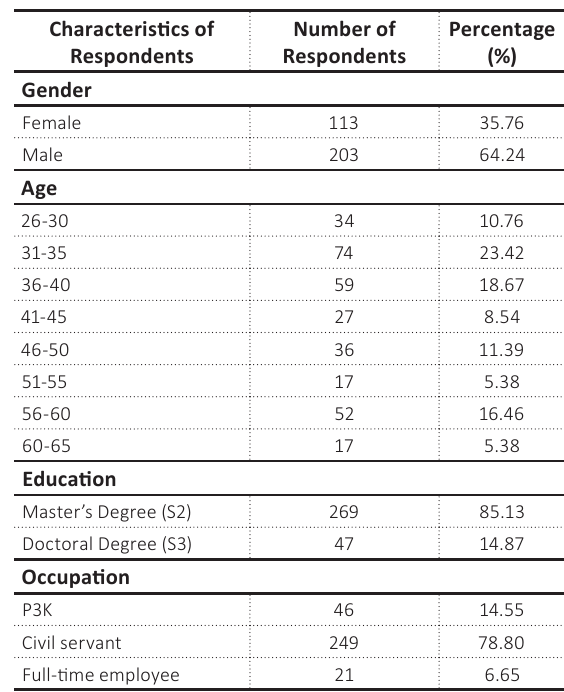
Table 1. Respondents’ characteristics